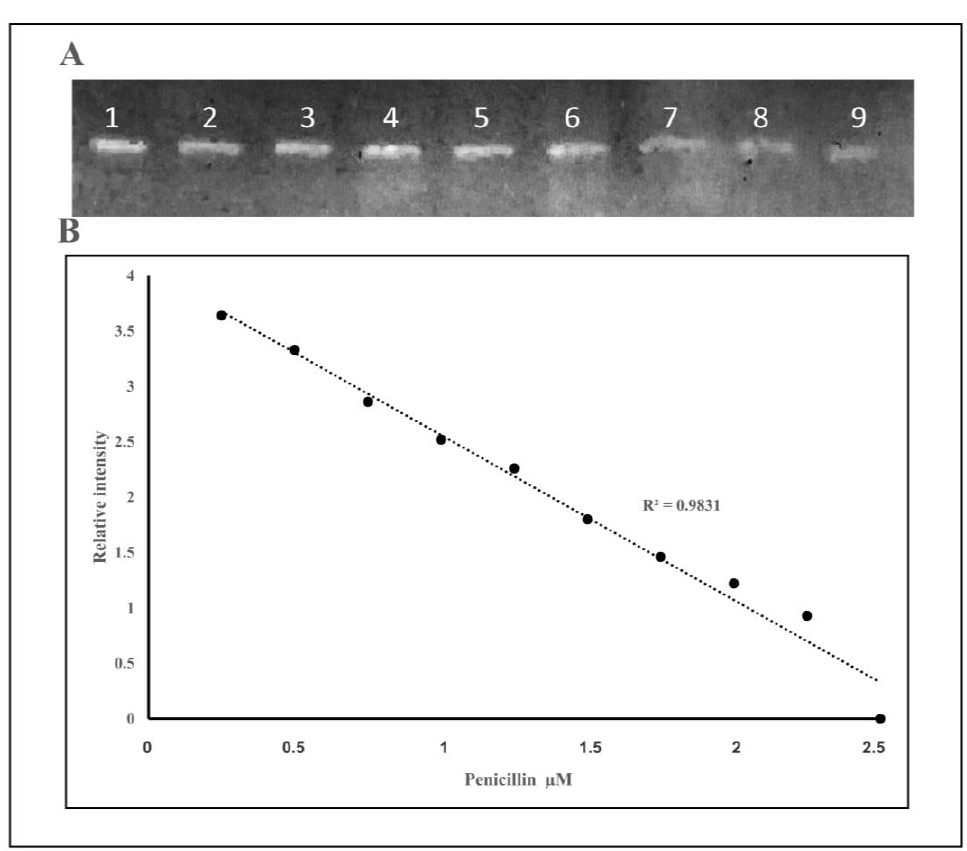
Figure 7. ( A ) Lanes (1–9): SDS-page of the binding reaction of 1 µ M soluble PBP2x* with 0.15 to 2.5 µ M of Penicillin G, followed by addition of 1 µ M of Bocillin FL (imaged by ChemiDoc-It ® 2). ( B ) Correlation between relative fluorescence intensity of Bocillin FL and penicillin G concentrations quantified by Gel-quant software from the image A.